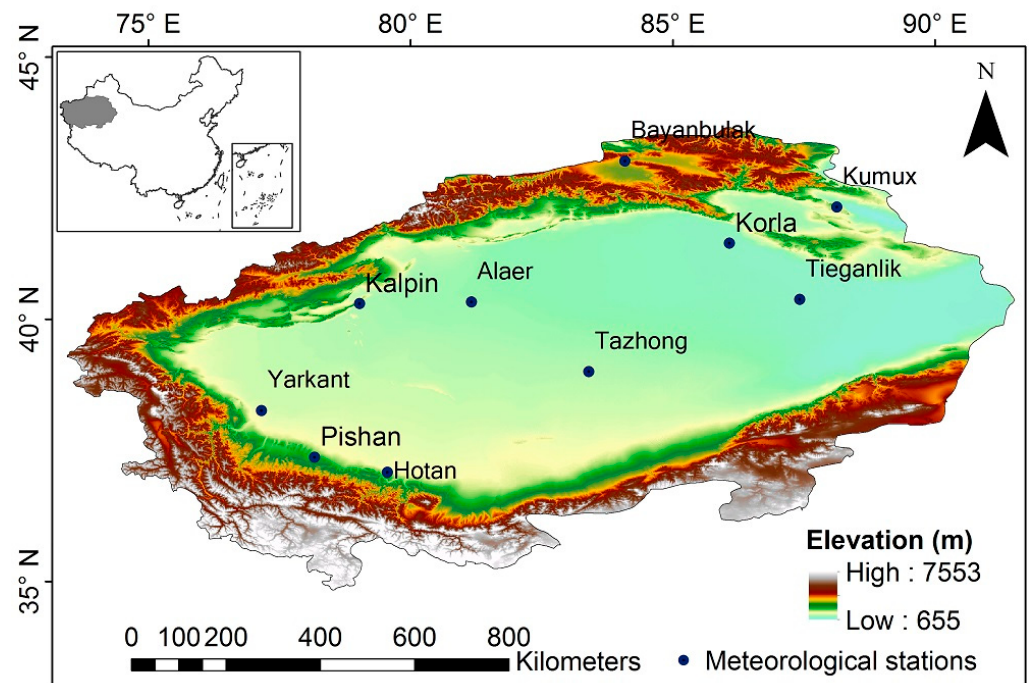
Figure 1. Study area locations of meteorological stations.